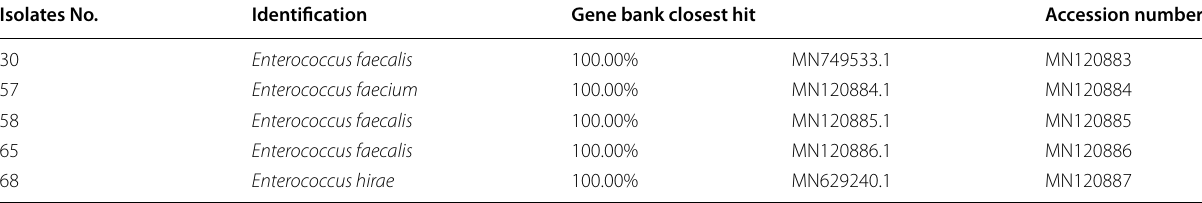
Table 3 Bacterial identification and accession numbers of isolates Isolates